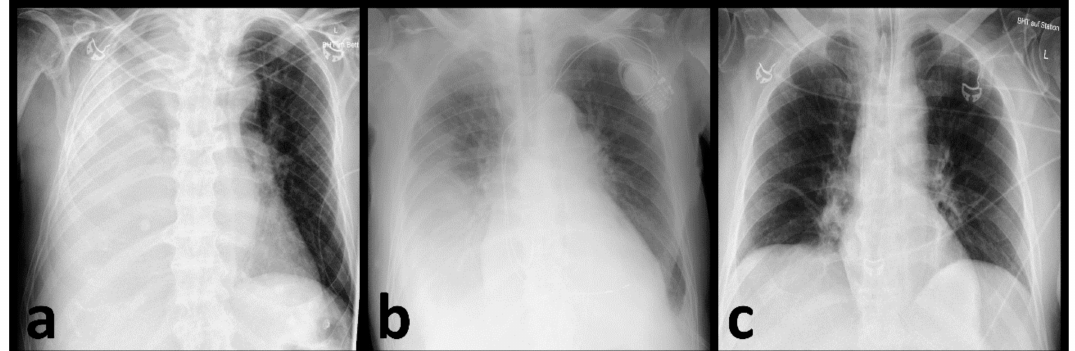
Figure 5. False positive assignments by the AI. Examples of chest radiographs with false positive assignments by the artificial intelligence possibly caused by large pleural effusions ( a , b ) or a small dystelectasis in the right lower field ( c